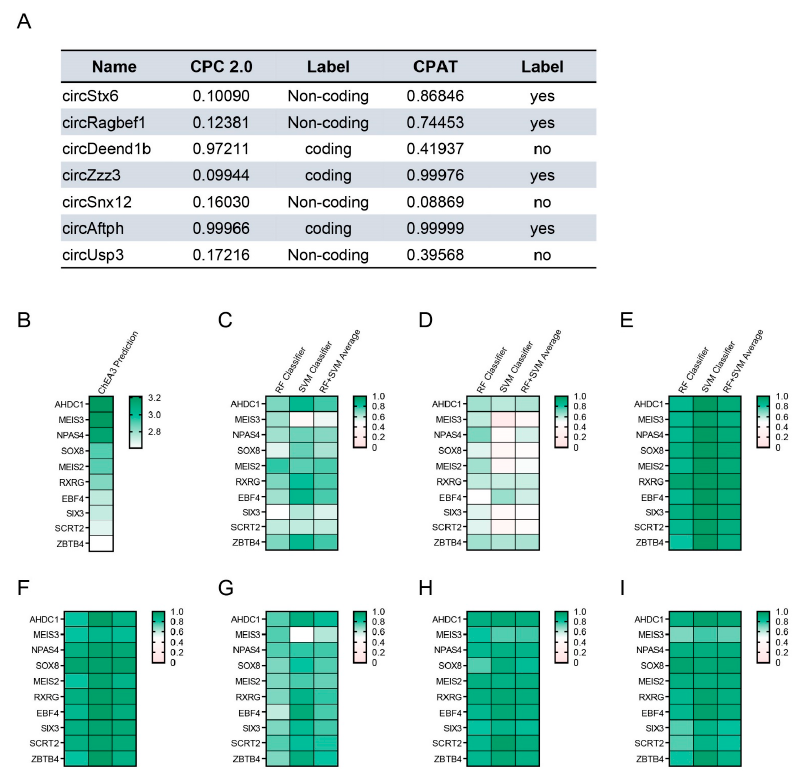
Figure 6. Characterization of circRNAs ( A ) The protein-coding potential of circRNAs was analyzed by CPC 2.0 (expressed as coding or non-coding) and CPAT (expressed as yes or no) tools. ( B ) The prediction of protein factors using ChEA3 that may regulate transcription of genes affected by HFD in the RNA-seq data. The color bar expresses the top ten ranking of the integrated score for ChEA3. ( C ) The interaction probability between circStx6 and transcription factors was predicted using RPIseq. ( D ) The interaction probability between circRagbef1 and transcription factors was predicted using RPIseq. ( E ) The interaction probability between circDeen1b and transcription factors was predicted using RPIseq. ( F ) The interaction probability between circZzz3 and transcription factors was predicted using RPIseq. ( G ) The interaction probability between circSnx12 and transcription factors was predicted using RPIseq. ( H ) The interaction probability between circAftph and transcription factors was predicted using RPIseq. ( I ) The interaction probability between circUsp3 and transcription factors was predicted using RPIseq. In ( C – I ), the color bar indicates the interaction probability score (0–1) between circRNAs and transcription factors. RF: random forest, SVM: support vector forest.